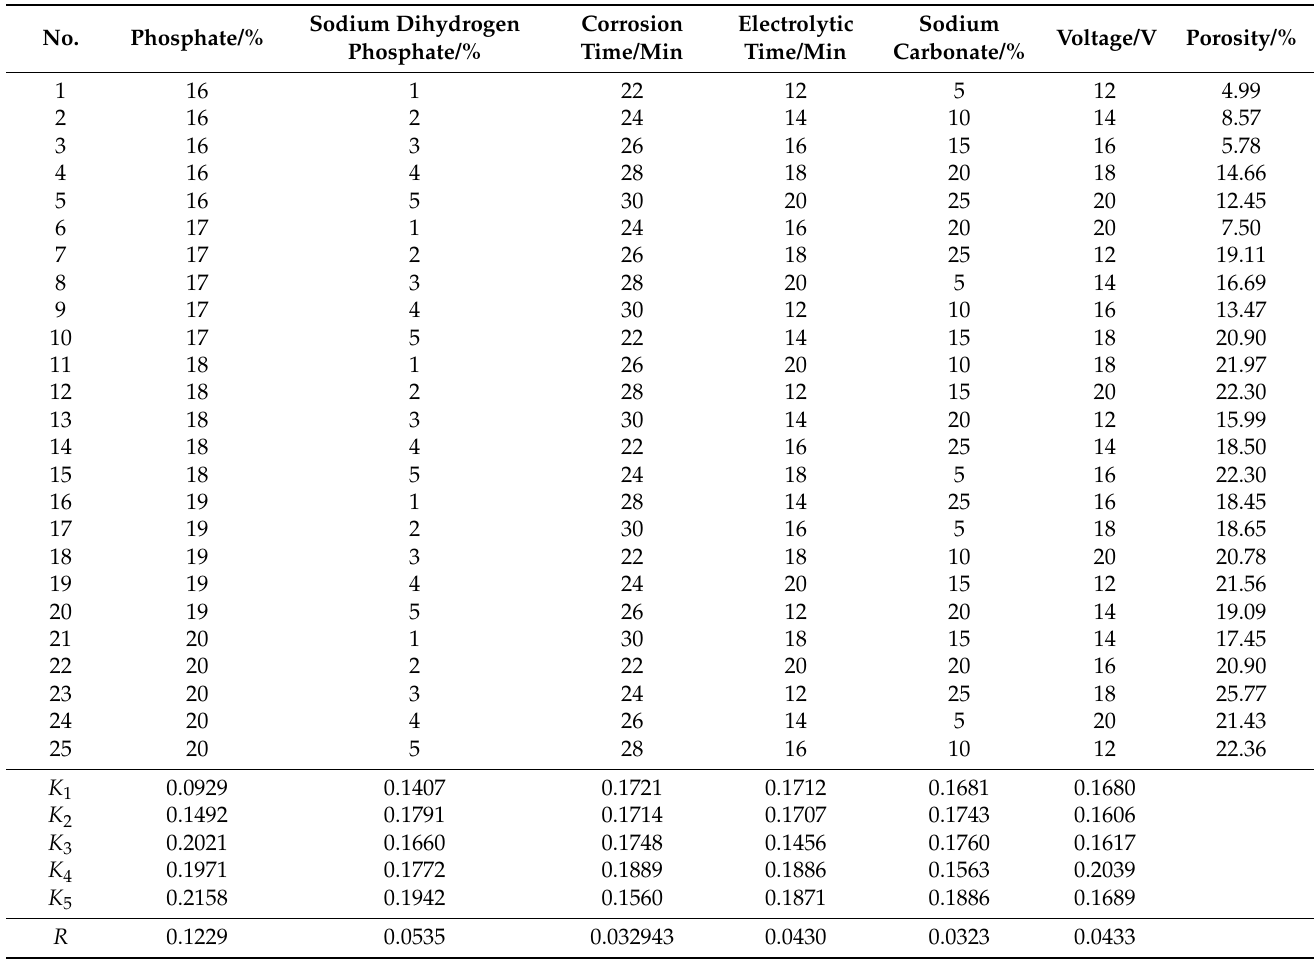
Table 3. Range analysis of orthogonal